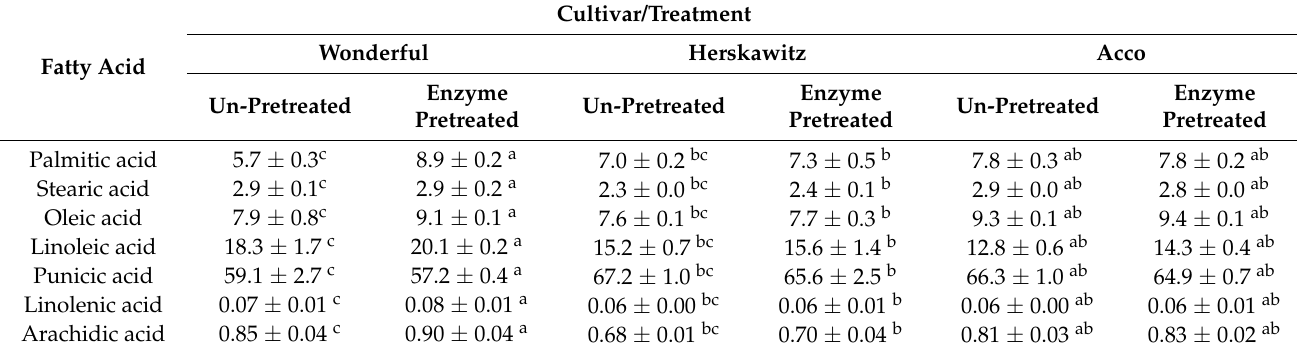
Figure 6. Representative gas chromatography – mass spectrometry (GC – MS) chromatograph of the fatty acids methyl esters (FAMES) from the pomegranate seed oil showing the major FAMES and their retention times. C16:0 = palmitic acid, C17:0 = heptadecanoic acid (internal standard), C18:0 = stearic acid, C18:1 = oleic acid, C18:2c = linoleic acid, C18:2t = linolenic acid, C18:3 = punicic acid, C20:0 = arachidic acid. Table 3. Fatty acid composition of un-pretreated and enzyme pretreated seeds (1.7%, 40 ◦ C, pH = 4.5 and 5 h) from three pomegranate cultivars.